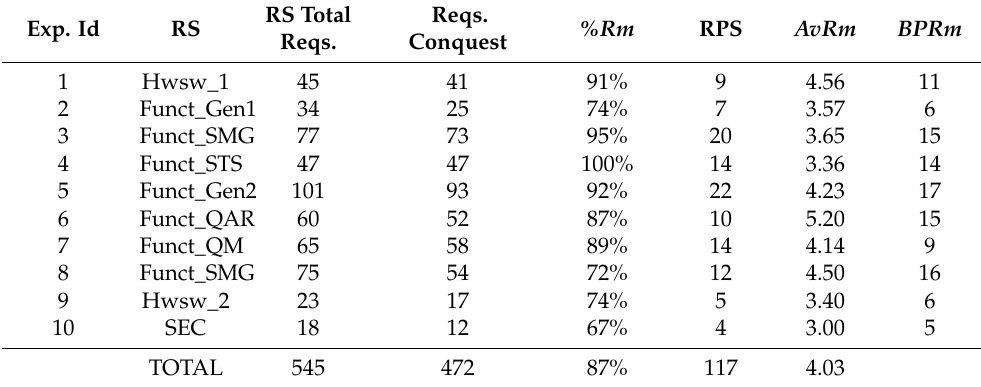
Table 7. Summary results.